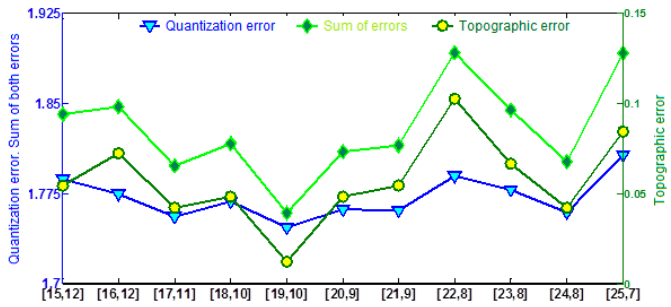
Figure 3. Topographic and quantization errors and the sum of both for different SOM structures.